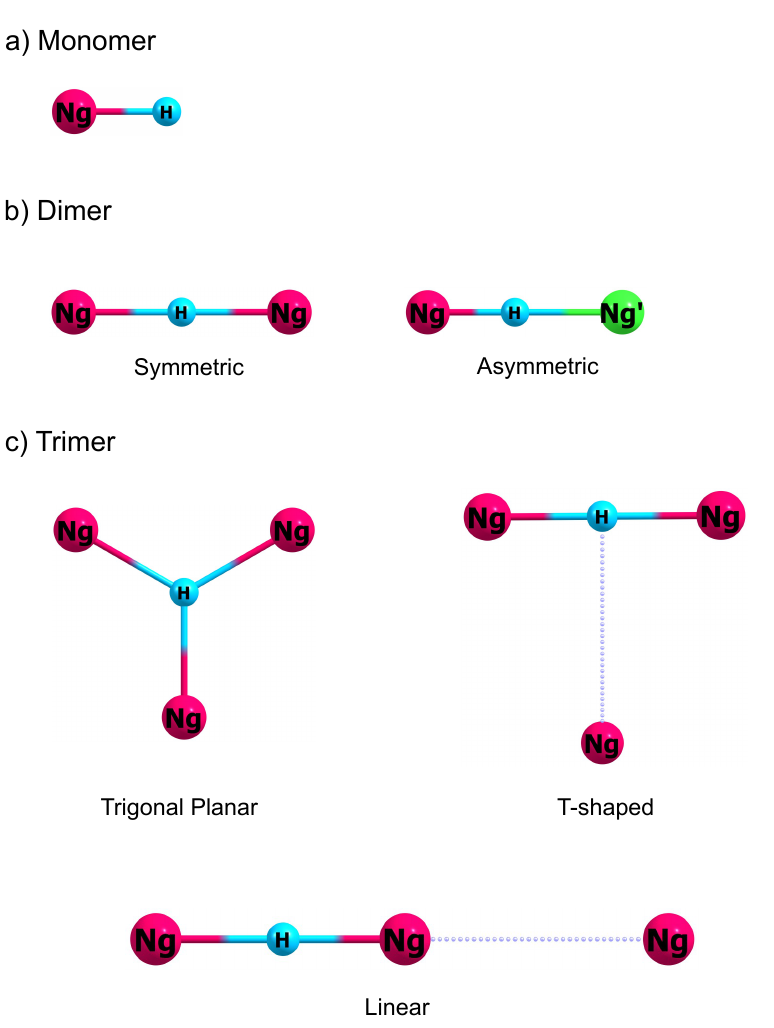
Figure 1. The structures of protonated noble gas clusters: ( a ) monomer, ( b ) symmetric and asymmetric dimers, ( c ) trigonal planar, T-shaped, and linear